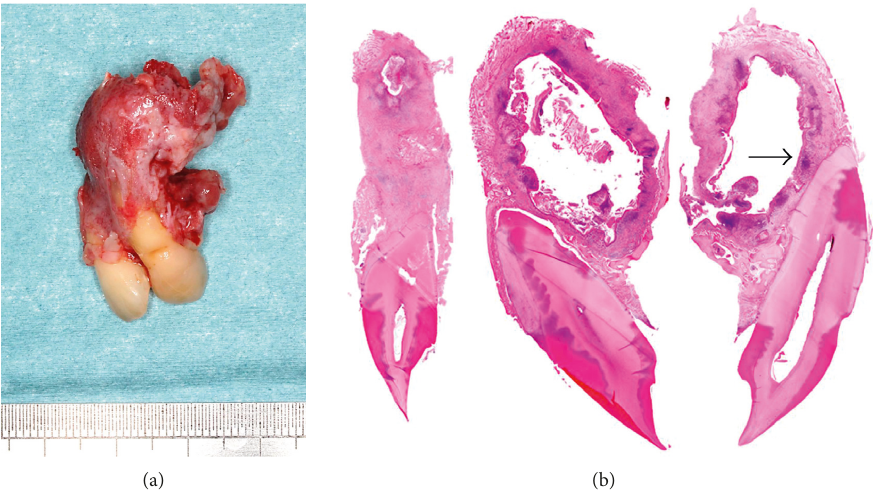
Figure 4: Macroscopic and survey view of the surgically resected specimen. (a) Surgical specimen. (b) Invasive atypical squamous cell nests in the cyst walls (black arrow) (HE; original magnification: × 1